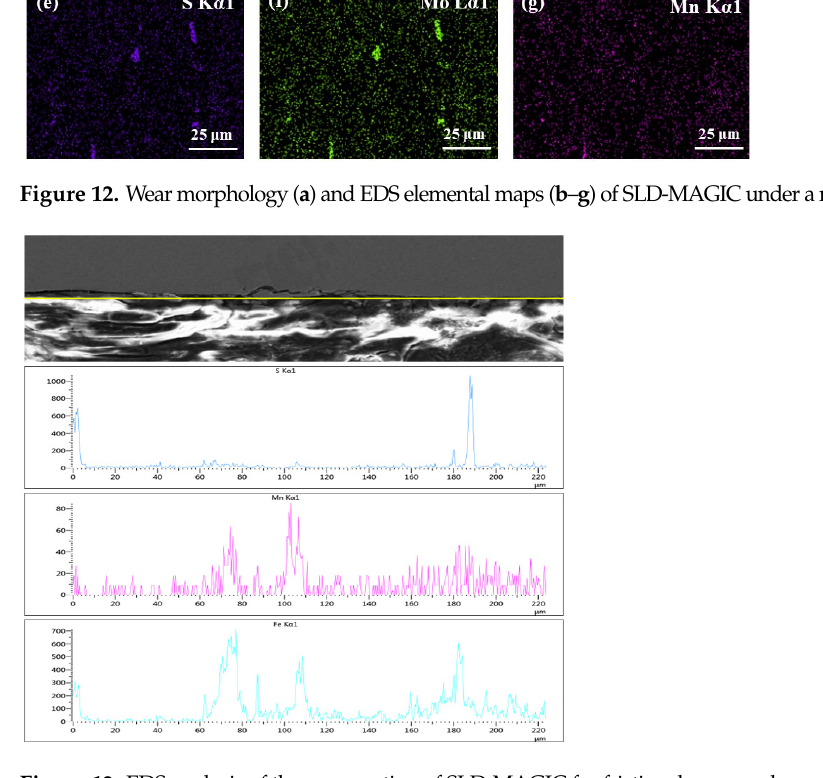
Figure 13. EDS analysis of the cross section of SLD-MAGIC for frictional wear under a normal load of 70 N.